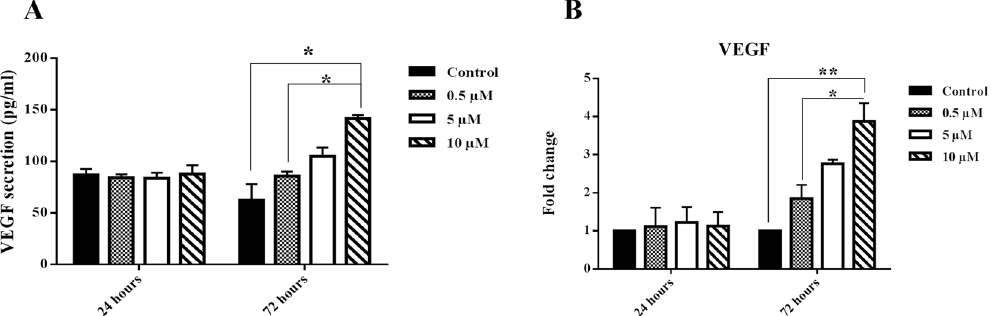
Figure 9. VEGF secretion and gene expression. ( A ) VEGF secretion and ( B ) VEGF mRNA expression in the islets in different concentrations of nobiletin. The experiment was done in triplicate from four donors and data were analyzed by Kruskal-Wallis and Post-hoc tests. Results were represented as mean ± SD. * p < 0.05 and ** p < 0.01.